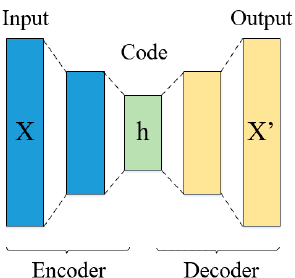
Figure 1. Example structure for an under-complete autoencoder.